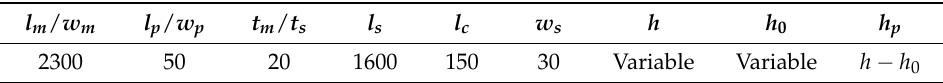
Figure 1. ( a , b ) Three-dimensional sketch and ( c , d ) main geometric specifications of the micro-switch. Table 1. Main geometric parameters of the micro-switch ( μ m).